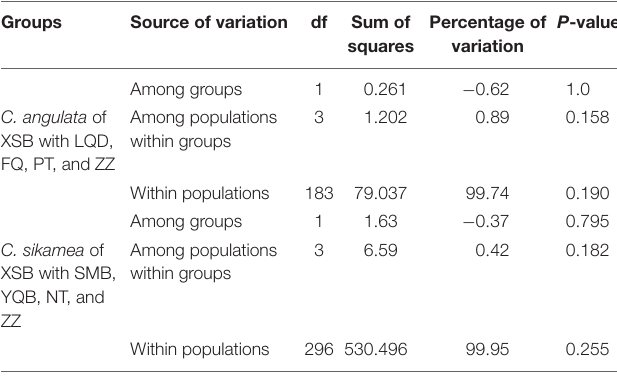
TABLE 6 | AMOVA of C. angulata and C. sikamea based on the COI sequence of XSB with other populations.